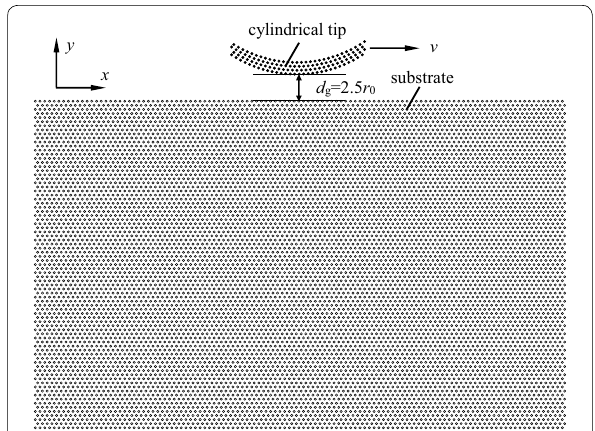
Figure 1 Two‑dimensional nanoscale sliding contact model between a rigid cylindrical tip and an elastic substrate